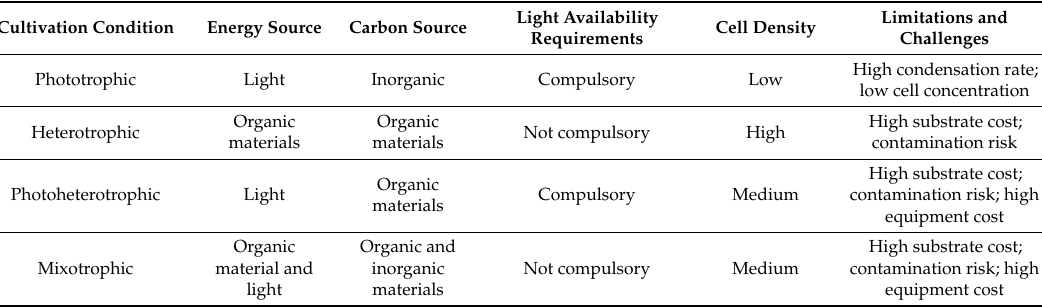
Table 1. Characteristics of di ff erent microalgae cultivation conditions [18,19].